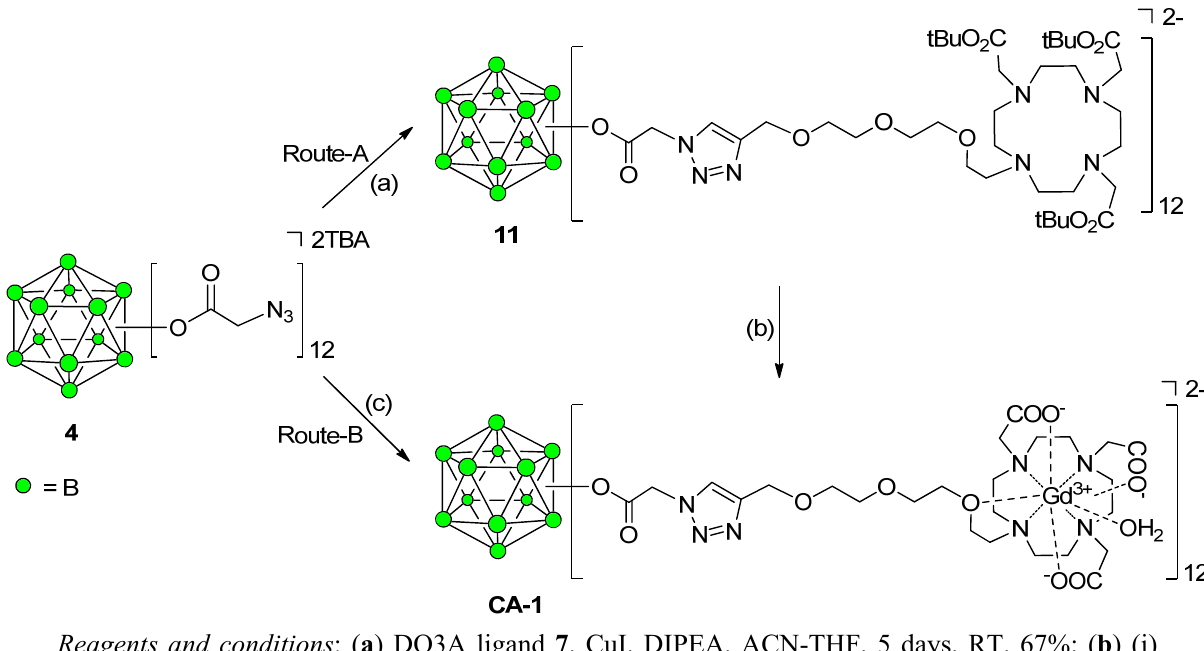
Scheme 3. Synthesis of closomer contrast agent CA-1